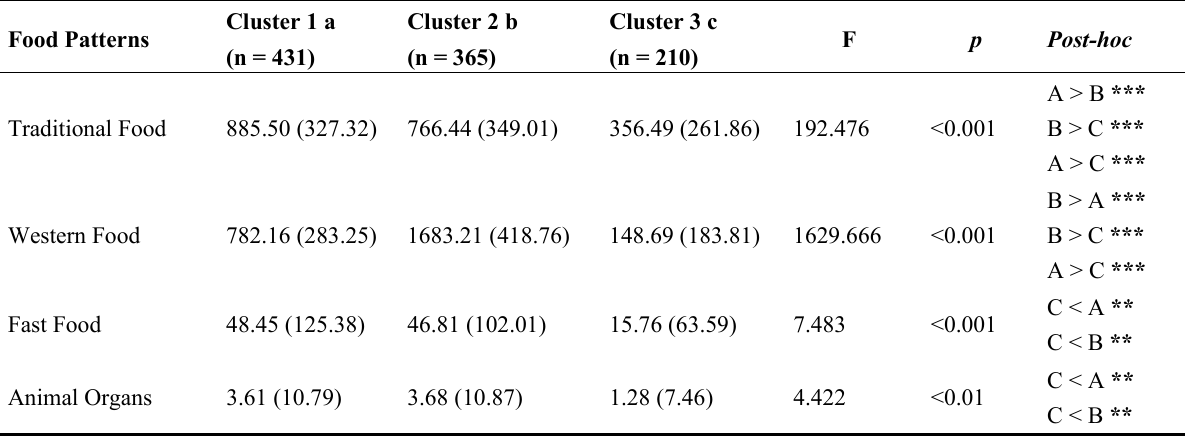
Table 2. Classification of subjects by cluster analysis using factor score.